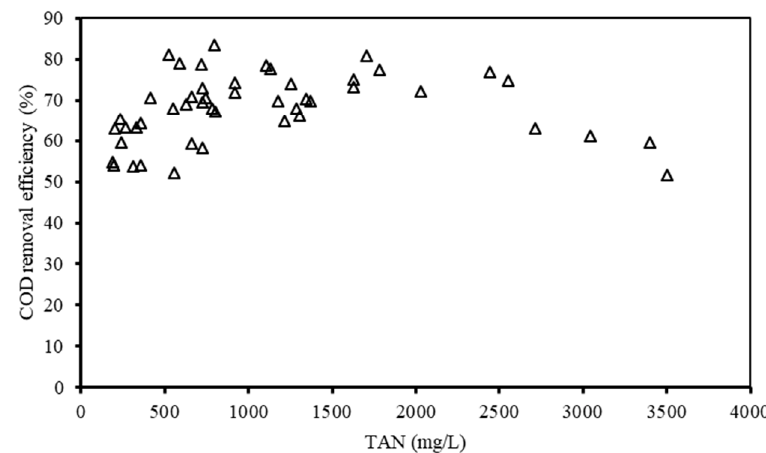
Figure 4. E ff ect of TAN on di ff erent organic removal e ffi ciencies. (TAN is not an independent variable Figure 4. Effect of TAN on different organic removal efficiencies. (TAN is not an independent variable 287 here; it may also correspond to one or more dependent here; it may also correspond to one or more dependent values.) 288